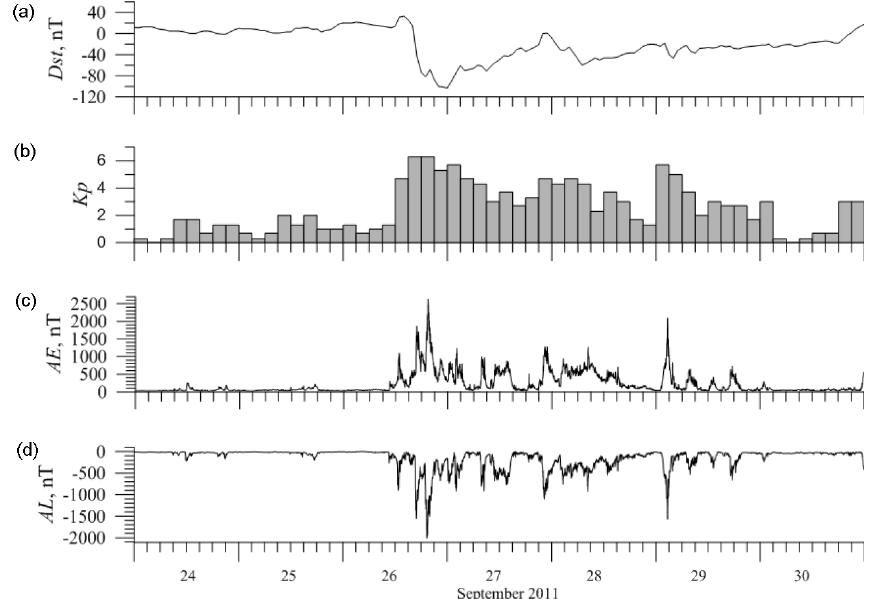
Figure 1. Behavior of the Dst, Kp, AE and AL indices of geomagnetic activity during disturbed periods from 24 to 30 September 2011.